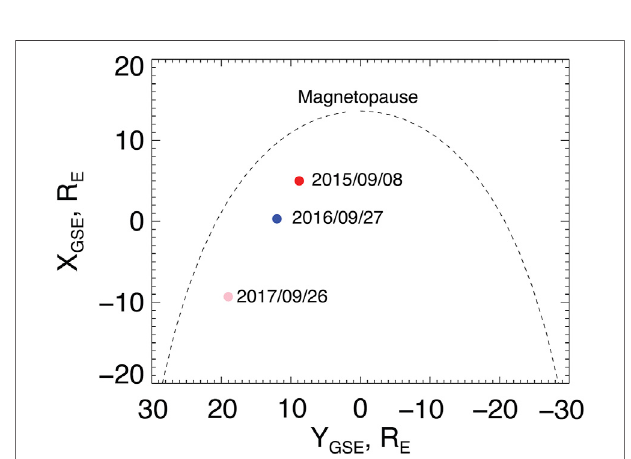
FIGURE 6 | The location of MMS in the X-Y GSE plane during the three KHI events shown in this study. The dashed line shows the nominal magnetopause from Shue et al.